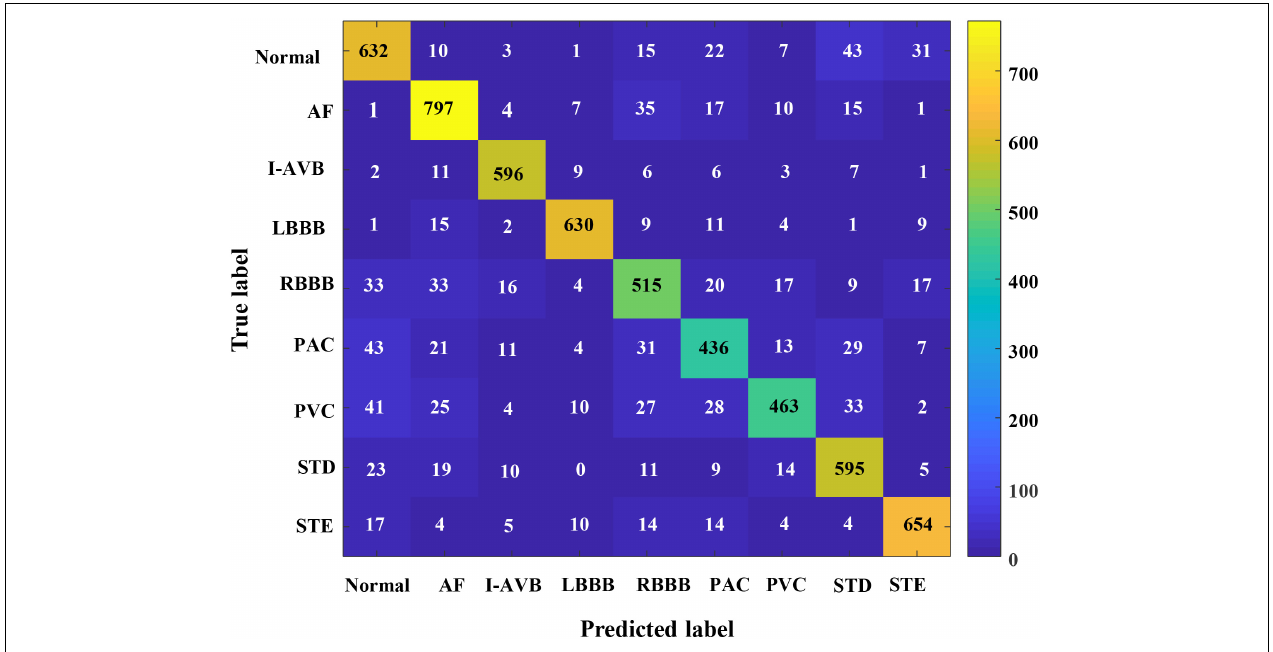
FIGURE 7 | The confusion matrix of the proposed method for CA classification. TABLE 3 | Classification performance of different reference